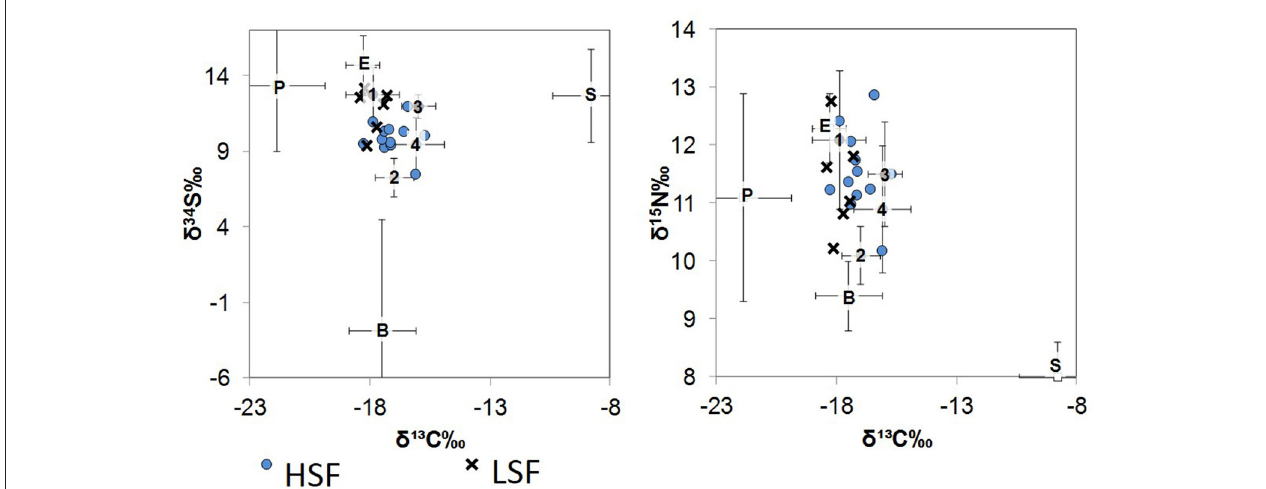
FIGURE 2 | δ 34 S vs. δ 13 C (left) and δ 15 N vs. δ 13 C (right) biplots of the St. George Sound ecosystem. Numbers represent fish values plotted according to groups (average ± one standard deviation): Group 1 (1): silver perch, Group 2 (2): mojarra, Group 3 (3): spot, and Group 4 (4): pinfish, pigfish, seabass, flounder, lizardfish, croaker, and snapper. Organic matter source value means ± one standard deviation are also plotted as P, plankton; B, benthic; S, seagrass; E, epiphytes. Whiskers representing the standard deviation for source values are symmetrical about the mean, edges were cut-off to improve graph readability. Blue circles represent the HSF dolphin isotope values, while × ’s represent the LSF dolphin isotope values.